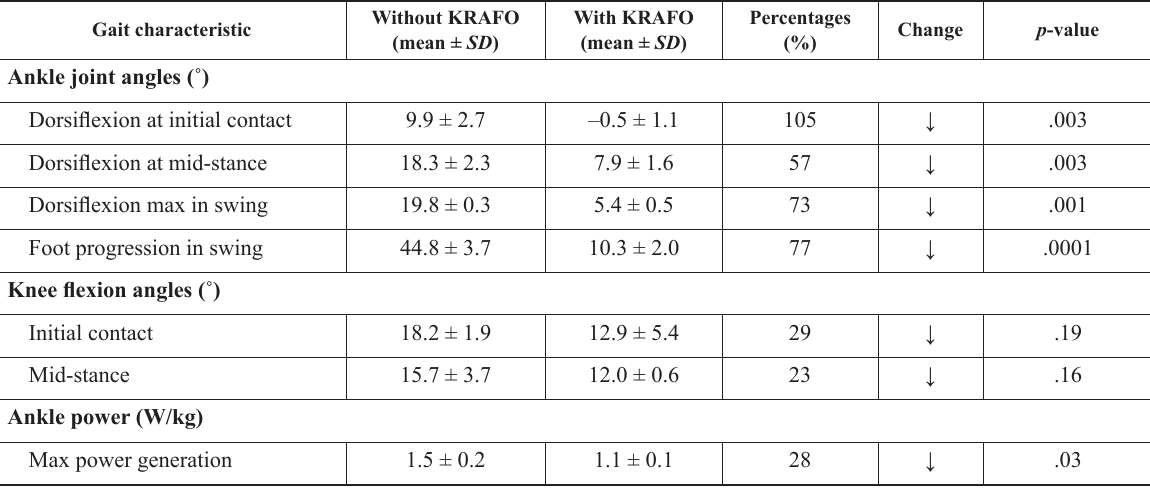
Without KRAFO With KRAFO Percentages Change p -value (mean ± SD ) (mean ± SD ) (%)